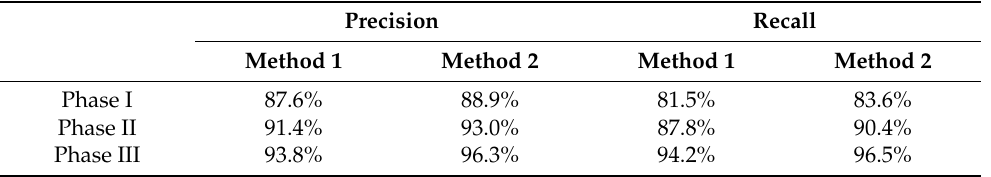
Table 12. Comparison of prediction results between the two methods.